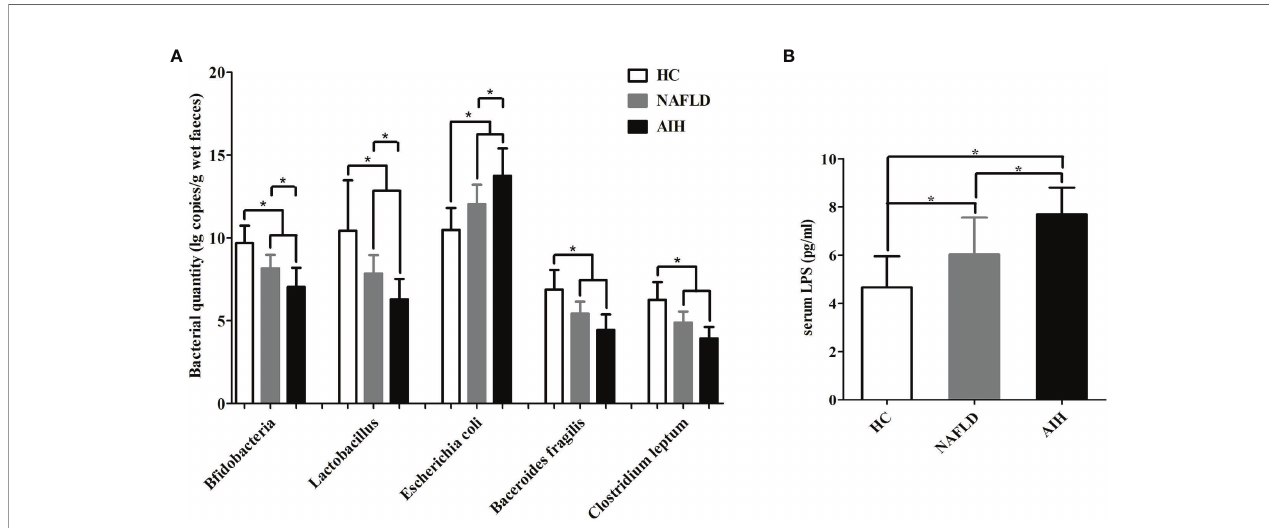
FIGURE 1 | Changes in the enteric microbiome and serum LPS levels of AIH patients compared to NAFLD patients and controls. (A) The levels of fecal Bi fi dobacteria , Lactobacillus , Bacteroides , Escherichia coli , and Clostridium leptum l g copies/g wet feces (copies per gram of wet feces); (B) the levels of serum LPS. The data are presented as the mean ± SD. *p <